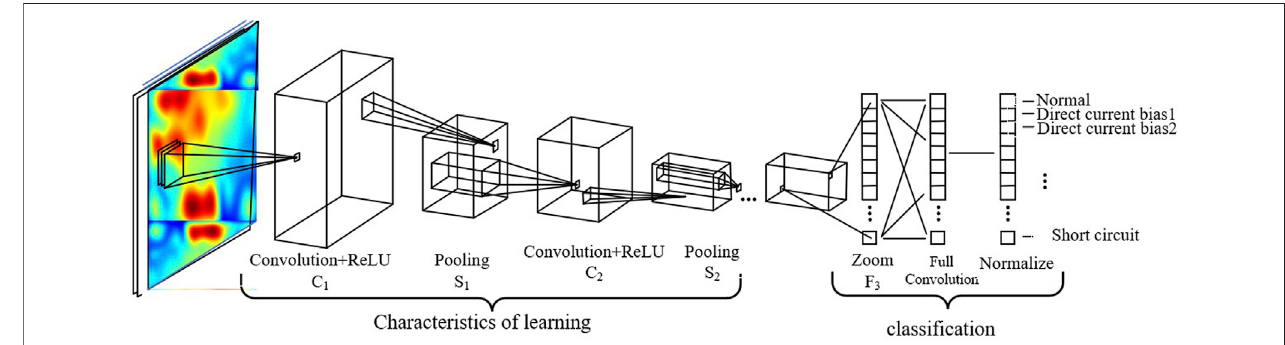
FIGURE 7 | Basic structure of convolutional neural network.